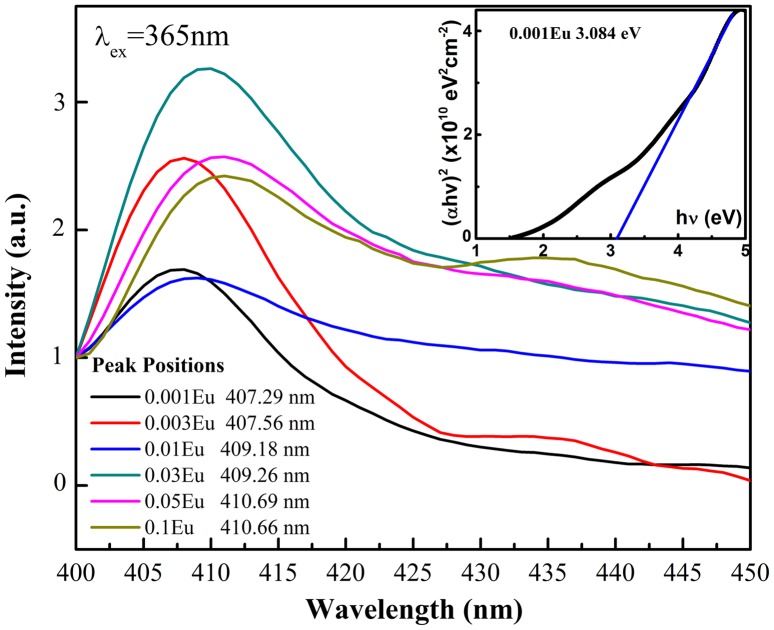
Near-band-edge photoluminescence of CuAl1-xEuxO2 excited at 365 nm. Inset shows the Tauc plot used for evaluating the optical band gap of CuAl0.999Eu0.001O2.